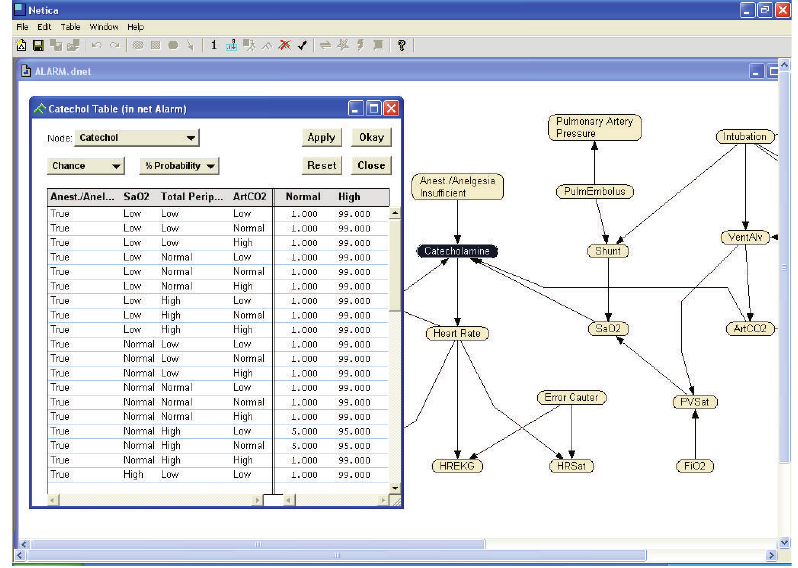
Figure 5: Conditional probability diagram for Alarm.dnet catechol variable.